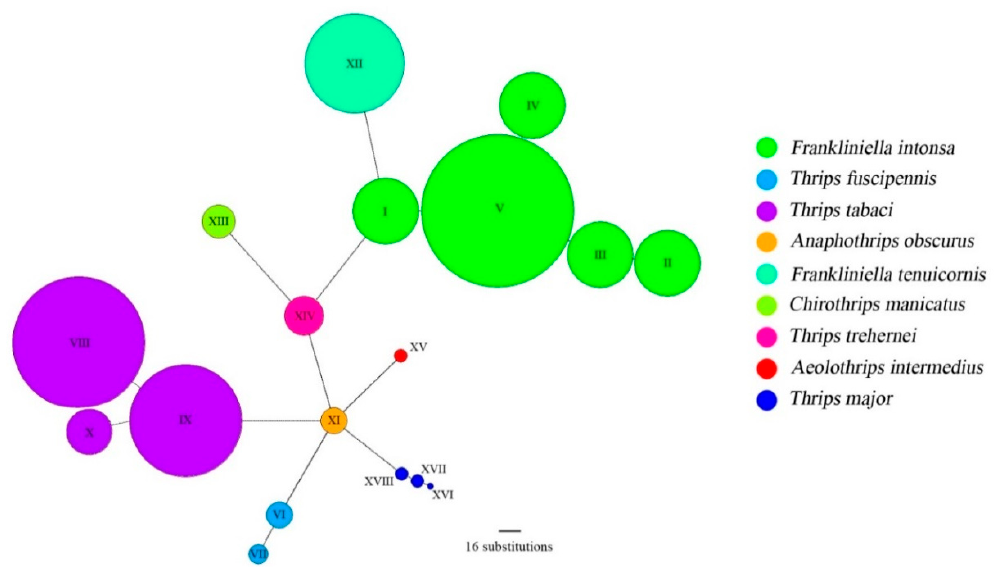
Figure 2. Haplotype networks based on COI sequences. Color codes indicate the different species identified, as shown in the legend, and are the same reported in the phylogenetic analysis (Figure 1). The size of the circles is proportional to the frequencies of the represented haplotypes.